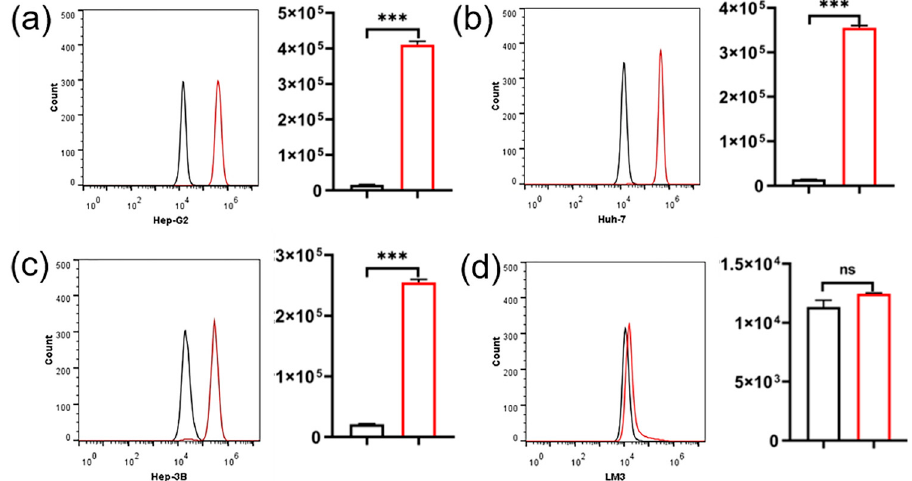
Figure 4. Flow cytometry histograms of different cell lines, ( a ) Hep-G2, ( b ) Huh-7, ( c ) Hep-3B, ( d ) LM3 after incubation with NDSA-L5 for 90 min.